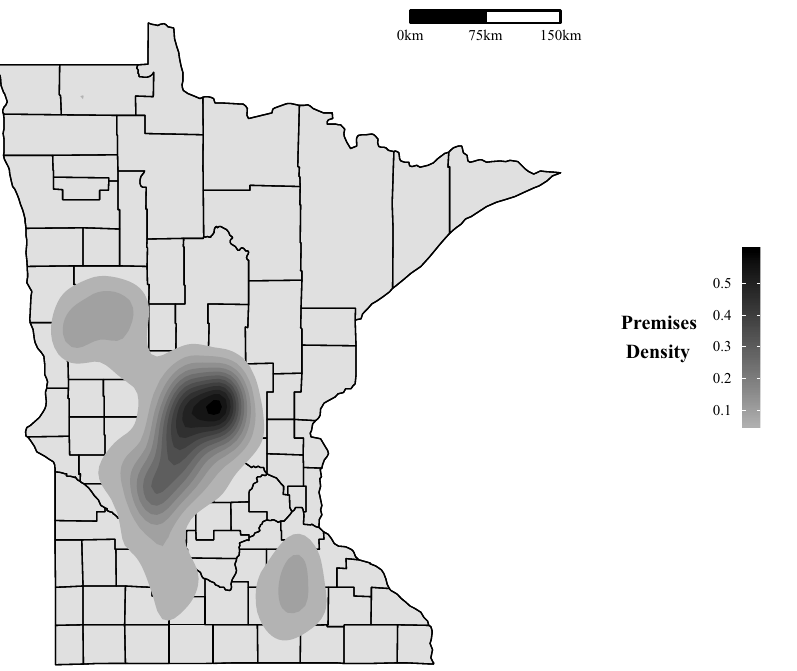
Fig 1. Density of poultry premises in Minnesota. Poultry density estimated from a bivariate normal kernel density [8].